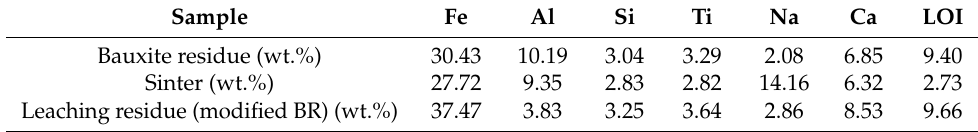
Figure 4. Comparison of the XRD profile of bauxite residue, sinter after bauxite residue sintering sintered with sodium carbonate and modified BR after mild alkaline leaching (0.1 M NaOH) of sinter. Table 4. Chemical analysis of bauxite residue, sinter and leaching residue